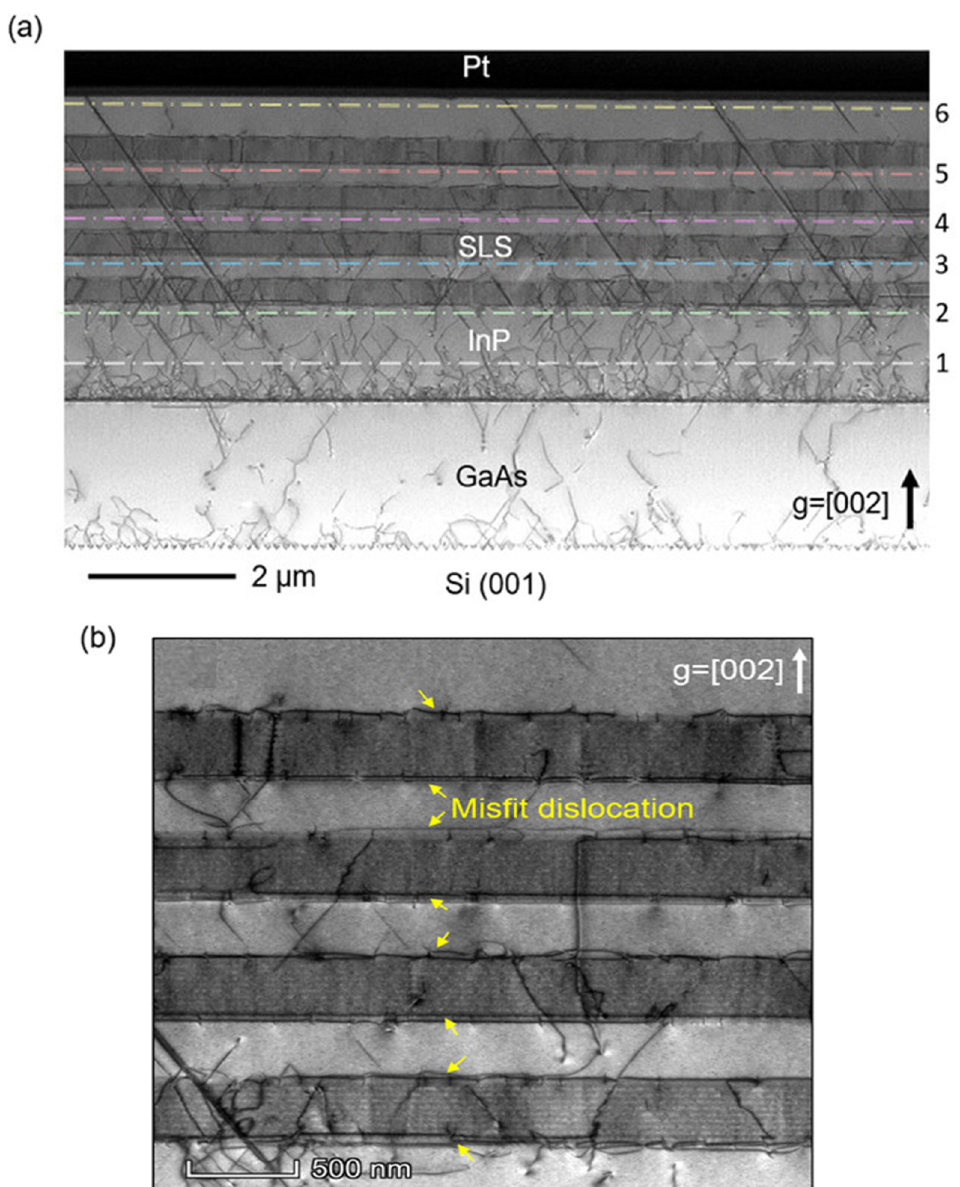
Figure 16. ( a ) Cross-sectional STEM image of InP-on-Si showing the generation and propagation of TDs and stacking faults. ( b ) Zoomed-in STEM images of SLSs DFLs region showing the propagation of TDs. Reprinted with permission from Reference [149] © 2020 American Institute of Physics.